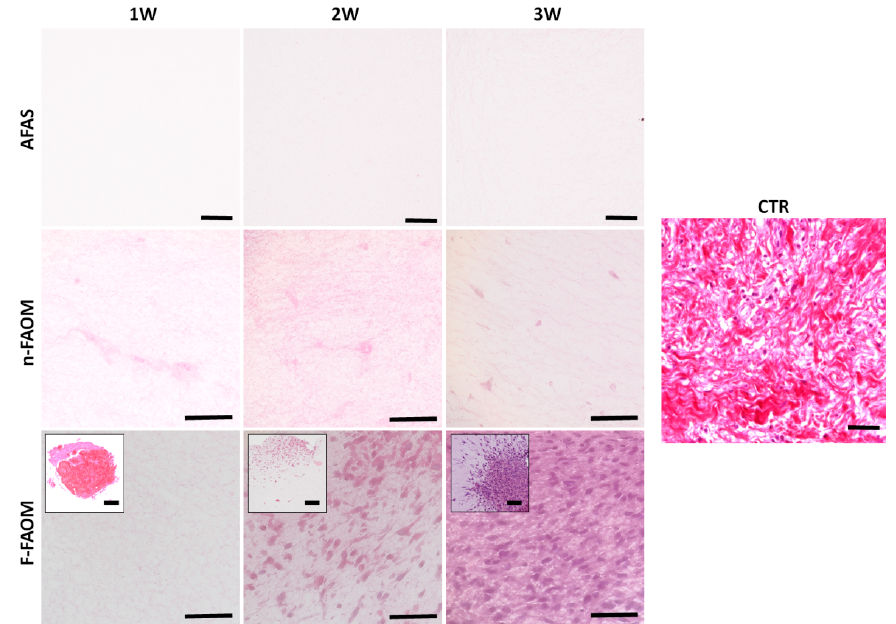
Figure 5. Histochemical analysis of controls and biofabricated oral tissues using Picrosirius red staining. CTR: control native oral mucosa; AFAS: acellular fibrin–agarose scaffolds; n-FAOM: non-functionalized fibrin–agarose oral mucosa stroma substitutes using isolated primary cell cultures of